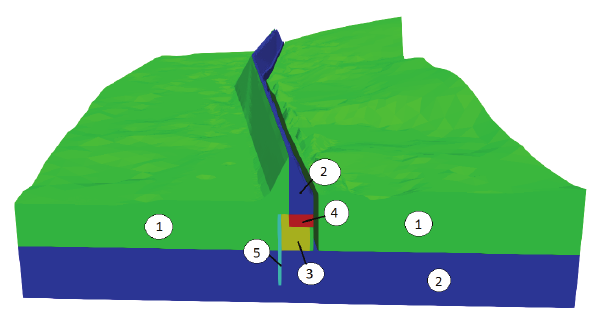
Figure 10: Area of change of potential Ψ to a negative sign on the 15th day of reservoir filling.